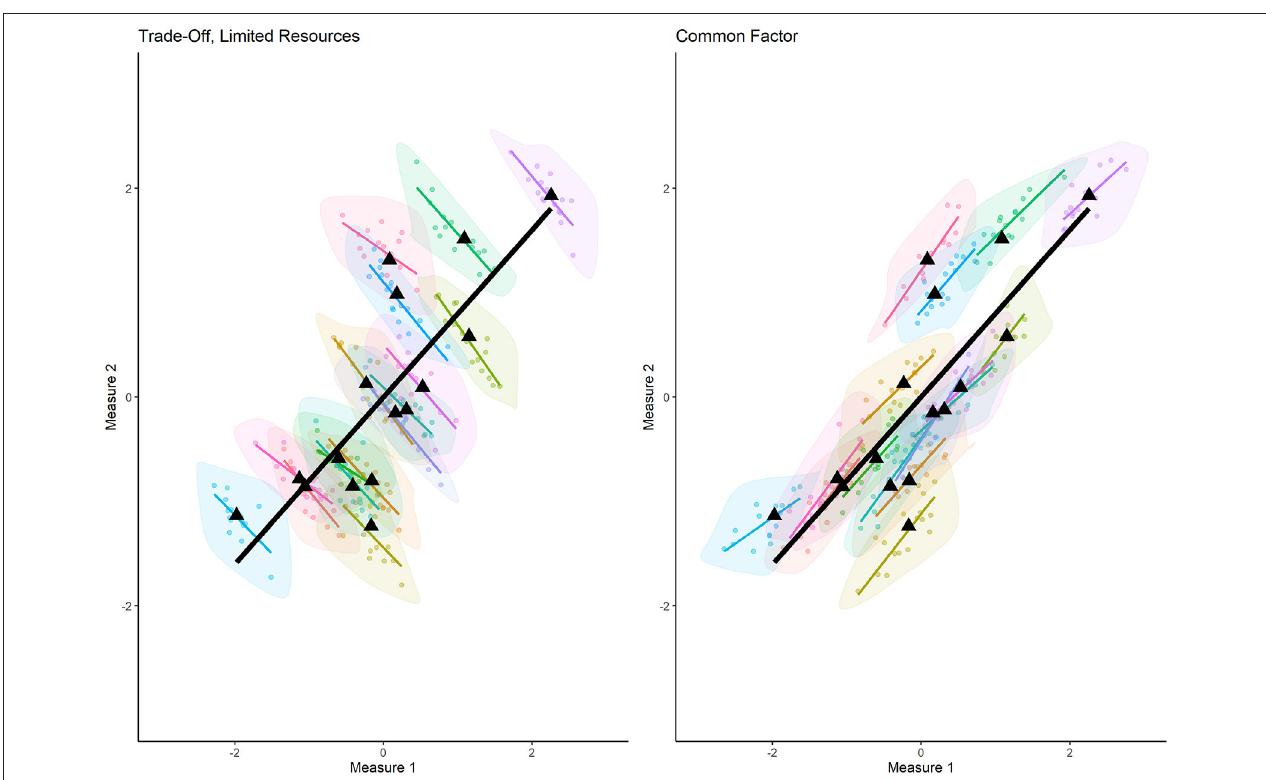
FIGURE 1 | Simulated data illustrating the two scenarios described in this opinion paper that can occur when investigating the correlations between two theoretically-linked measures on a within-person level. The different colors denote different “participants”, the thin colorful lines illustrate the within-person correlations for each simulated participant. The black triangles are places in the mean values for the two measures for each participant and the thick black lines are the between-person correlations resulting out of these averaged values. In the left panel we illustrate what a trade-off scenario would look like and in the right panel what a common factor scenario would look